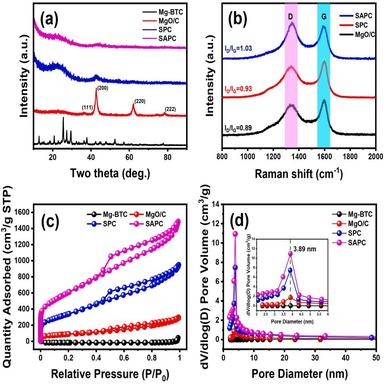
(a) XRD patterns of Mg-BTC, MgO/C, SPC and SAPC; (b) Raman spectra of MgO/C, SPC and SAPC; (c) Nitrogen adsorption-desorption isotherm and (d) Poresize distribution of Mg-BTC, MgO/C, SPC and SAPC.